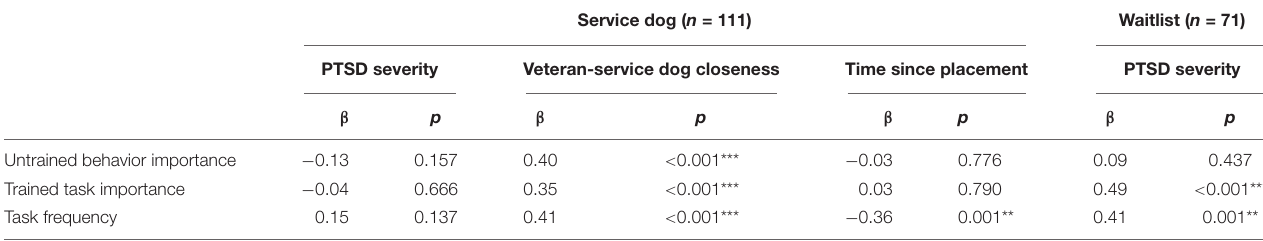
TABLE 5 | Relationship of PTSD severity, veteran-service dog closeness, and time since placement with importance of untrained behaviors and trained tasks for PTSD symptoms and frequency of task use among veterans with service dogs or on the